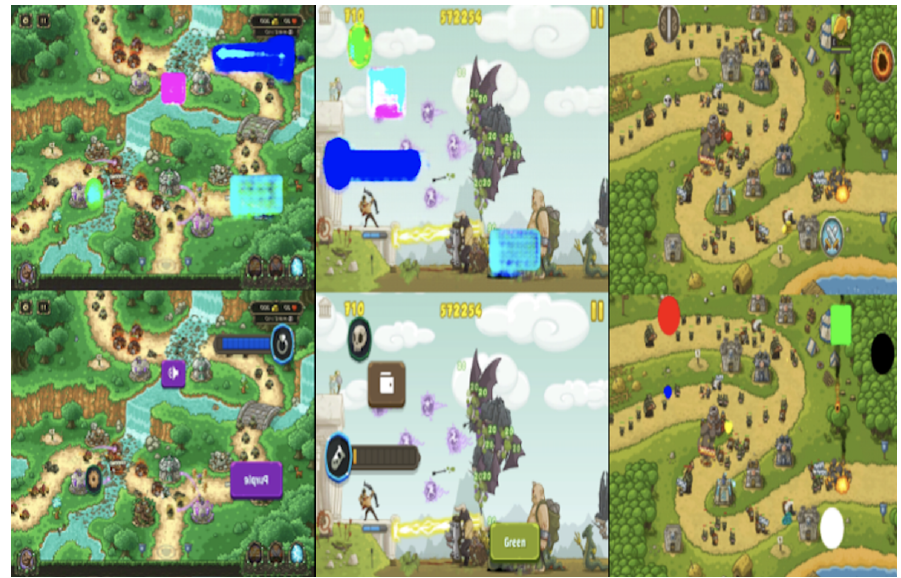
Figure 8. Network performance experiment results. (left: original Pix2Pix generator with 16 × 16 patch Size, middle: original Pix2Pix generator with 80 × 80 patch size, right: modified Pix2Pix generator with 70 × 70 patch